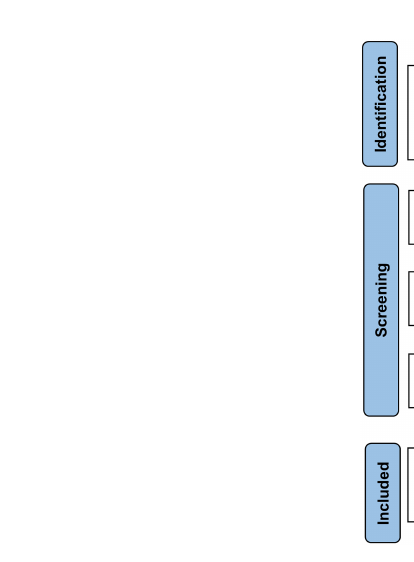
FIGURE 1 | Numbers of included and excluded papers derived from the PubMed search related to PBT in thoracic tumors.